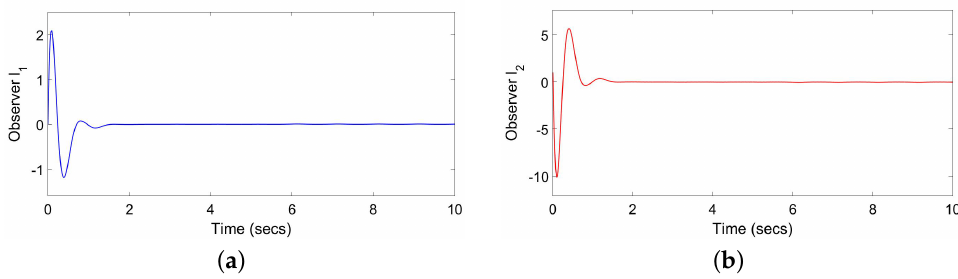
Figure 4. ( a ) Observer l 1 under probabilistic gain controller; ( b ) observer l 2 under probabilistic gain controller.